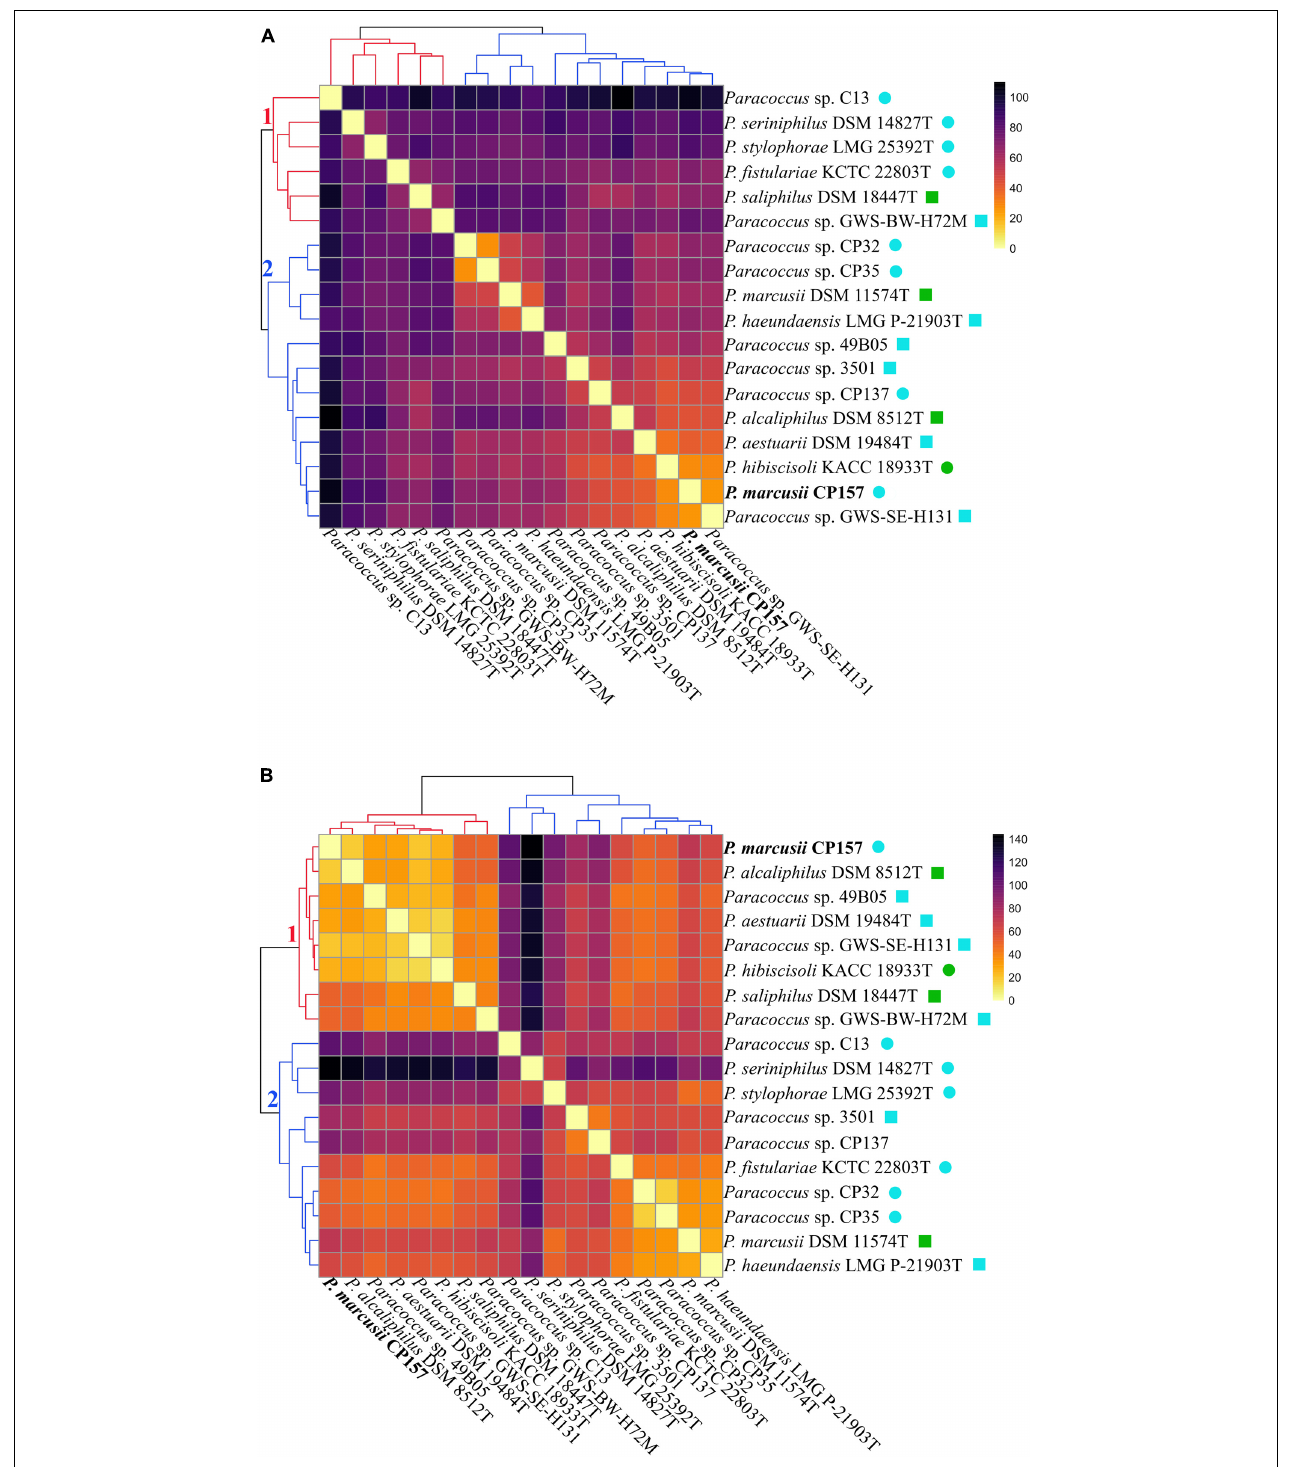
FIGURE 6 | Paracoccus culture extracts prepared with (A) XAD-7 or (B) XAD-16 are clustered according to their similarity (decreasing euclidian similarity from bright to dark) based on their composition (presence/absence of compounds) and the intensity of individual signals. The branches of the two major clusters identified within each data set are numbered and colored in red and blue. Compounds detected in MB extracts were removed and mean values of biological triplicates were normalized by z-scoring prior to plotting. Habitats of the respective strains are indicated as follows: (cid:4) marine + free-living, terrestrial + free-living, terrestrial + (cid:32)